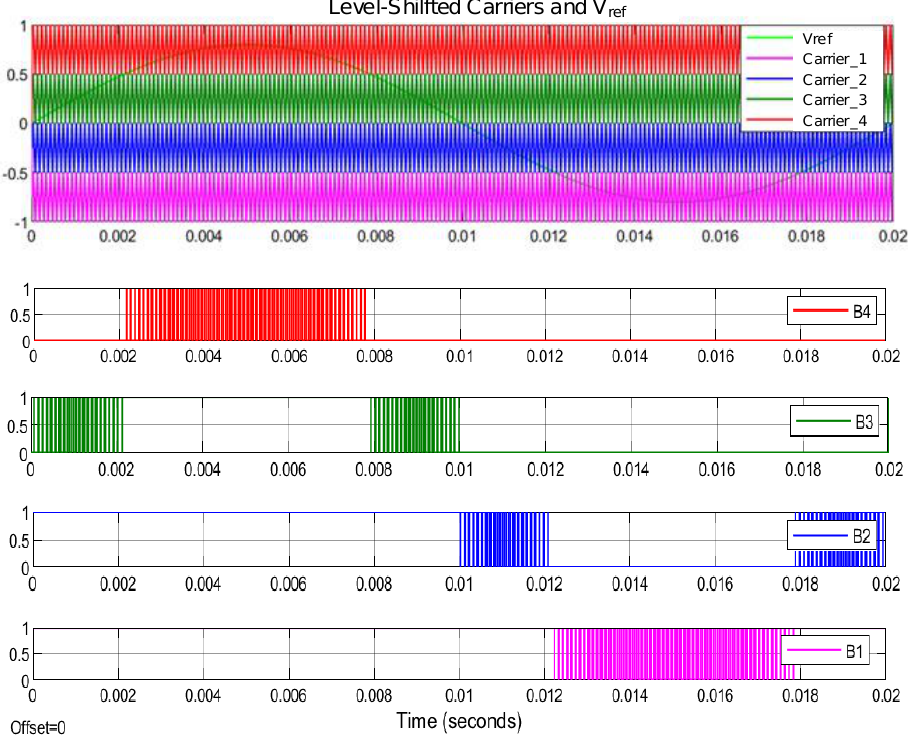
Figure 17. PWM control signal at gates of the switches B 1 . . . B 4 .